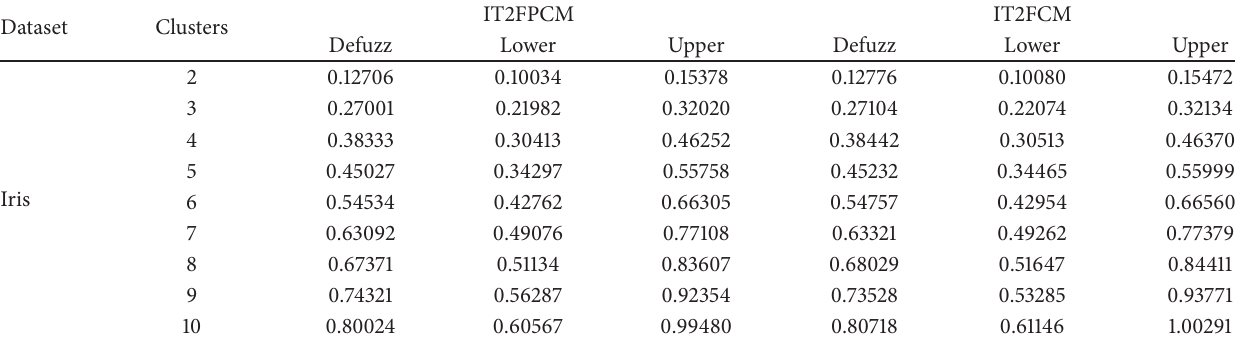
Table 10: Results of the IT2PE validation index to Iris Flower dataset clustering using IT2FPCM and IT2FCM algorithm with 𝑚 = [1.5, 2] and 𝜂 = [1.5, 2.5] as parameters.